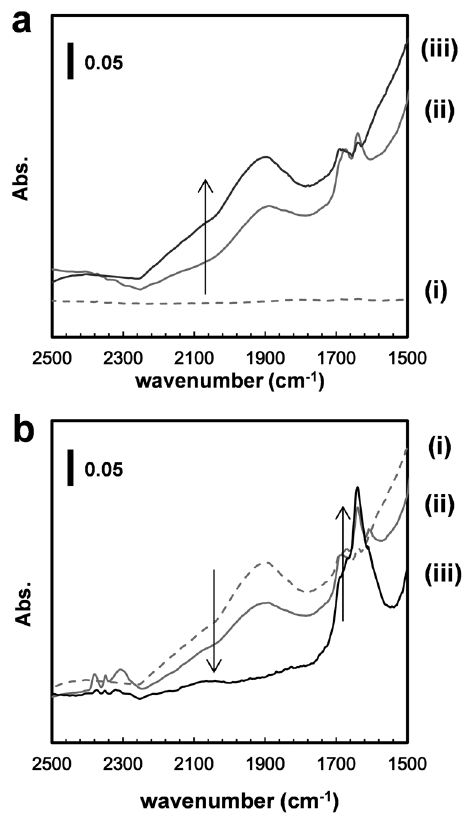
Fig. 4 In situ FTIR spectra of silicon powder mounted on TBAF(tBuOH) 4 . ( a -i) at room temperature, ( a -ii) 100 °C, and ( a -iii, b -i) after addition of EtOH vapor. The sample was then treated with CO 2 two times (1st: b -ii, 2nd: b